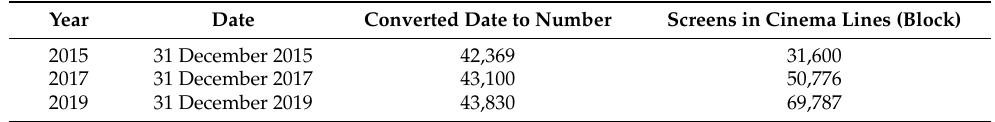
Table 1. Examples of data of screens (blocks) in cinemas.